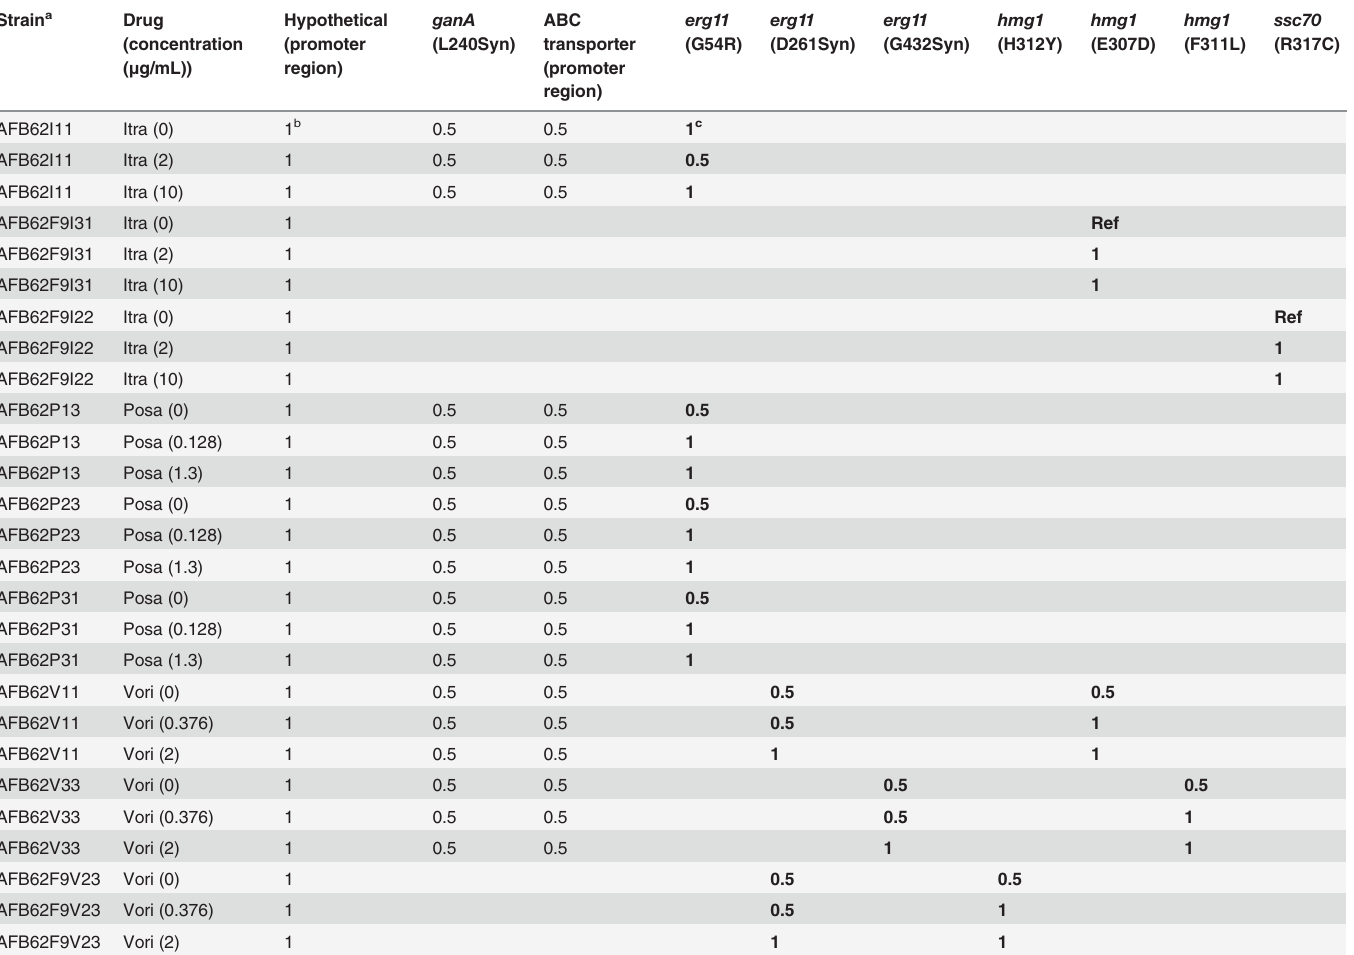
Table 2. Variant allele frequencies of relevant mutations in sequenced pools of mating offspring under no drug, intermediate, and high-level selec- tion for each drug. Strain